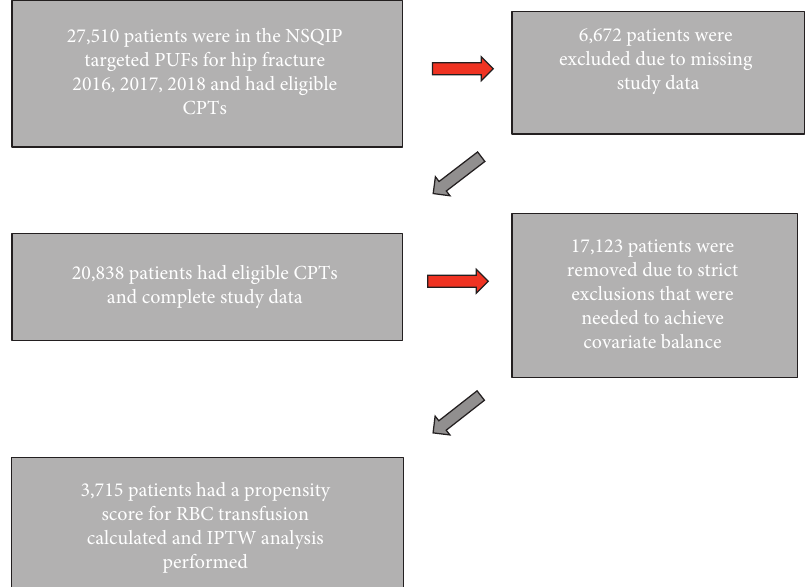
Figure 1: Flow diagram for the study. CPT � current procedural terminology, IPTW � inverse probability of treatment weighting, NSQIP � National Surgical Quality Improvement Program, PUF � participant use file, and RBC � red blood